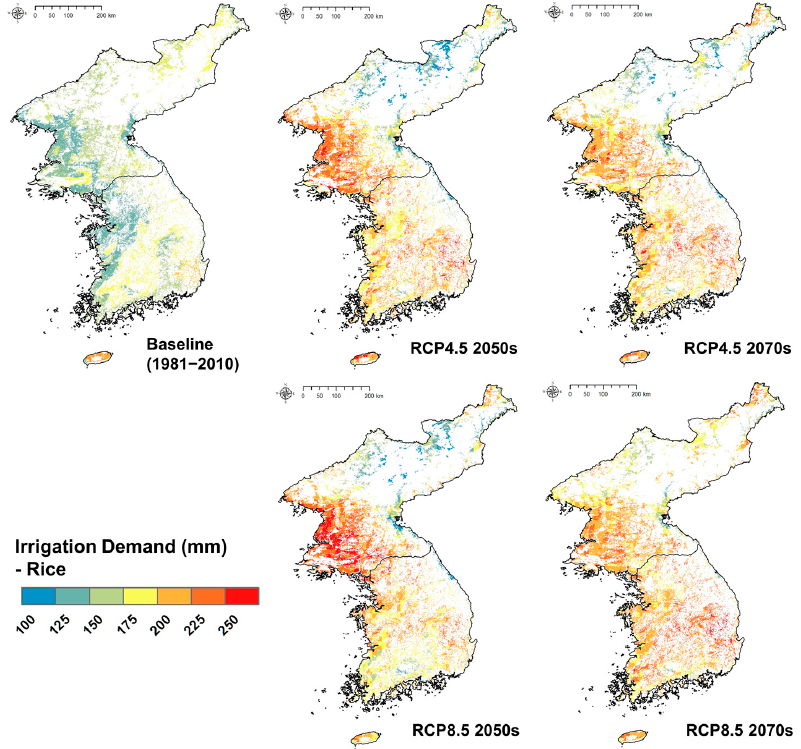
Figure 6. Agricultural water demand under baseline and future climate conditions in the Korean Peninsula. Table 3. Statistics of agricultural water demand and forest water supply under baseline and future climate conditions. Forest Water Supply